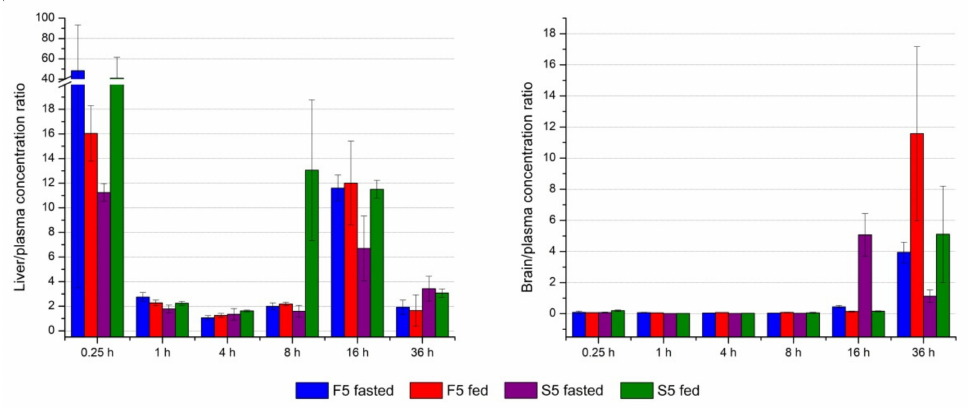
Figure 8. Ratio between DK-I-60-3 concentration in liver ( left ) and brain ( right ) in each time